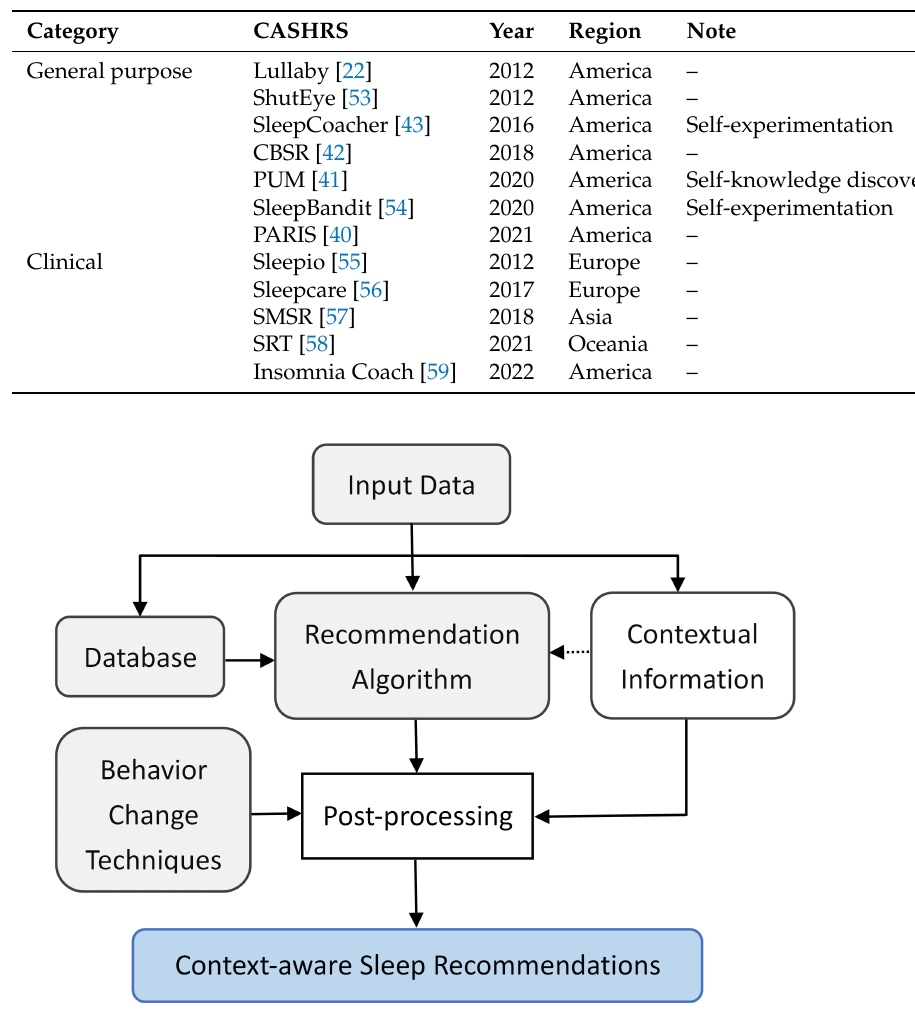
Figure 1. Architecture of